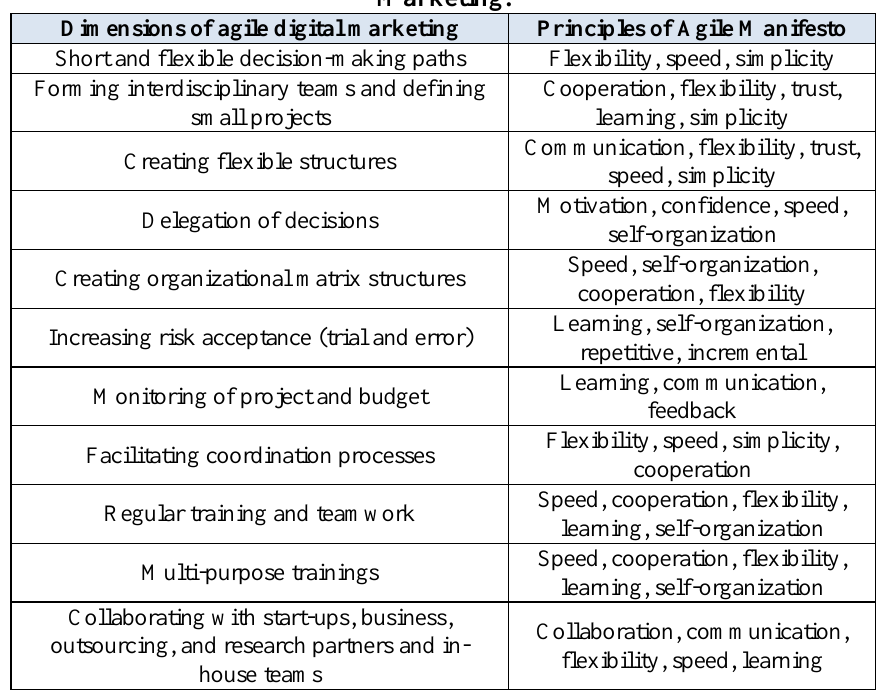
Table 5. Some Agile Strategies in the Agile Dimensions of Digital